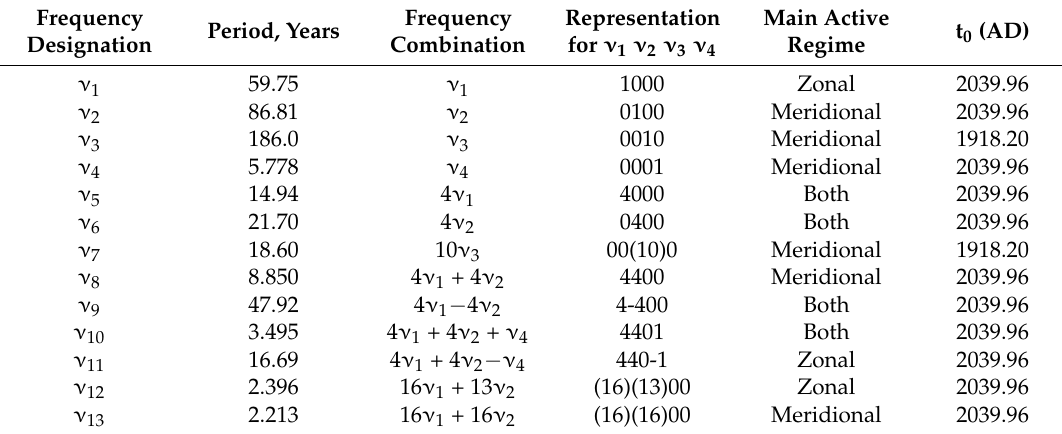
Table 14. Tidal frequency components in climate oscillations examined in this paper. The penultimate column lists the regime in which the components show greatest responses in the climate oscillations